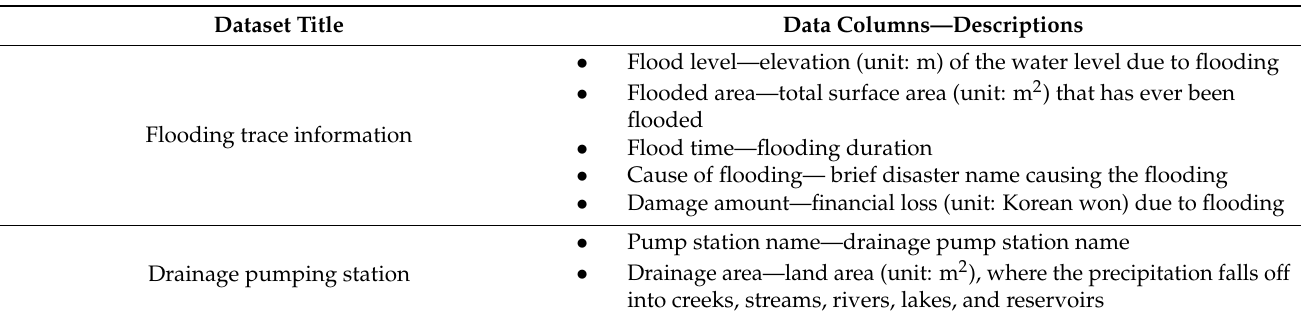
Table 1. Descriptions of the principal datasets selected from the open dataset related to flooding